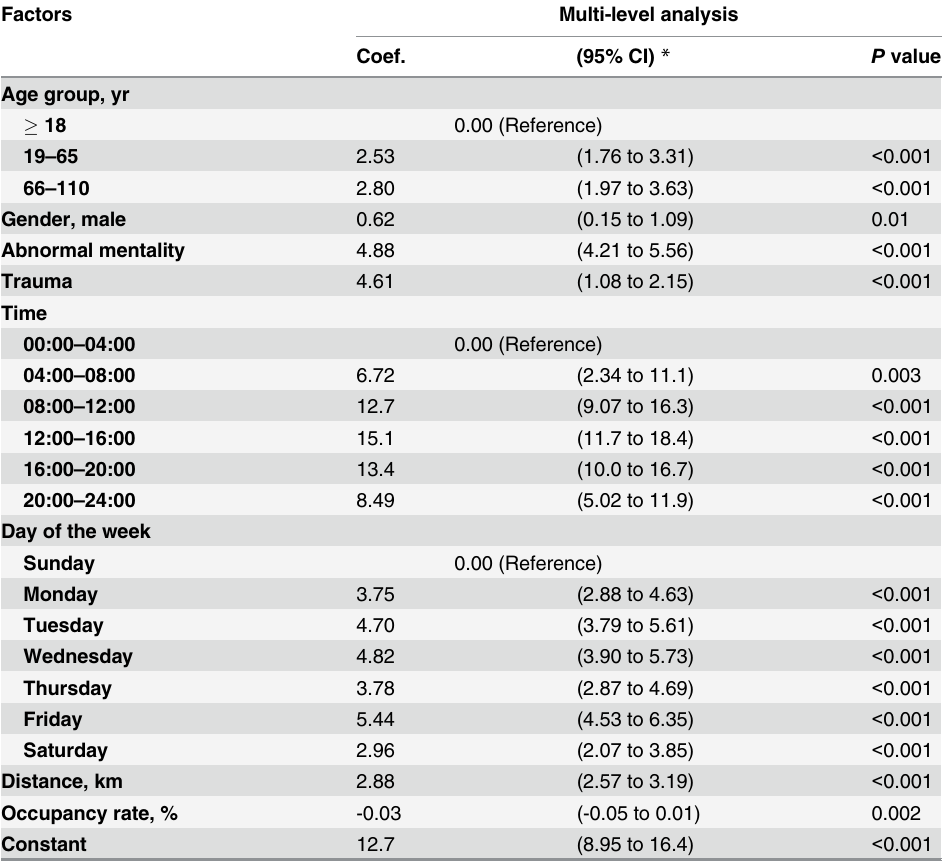
Table 3. Subgroup analysis of EDs with occupancy rate >